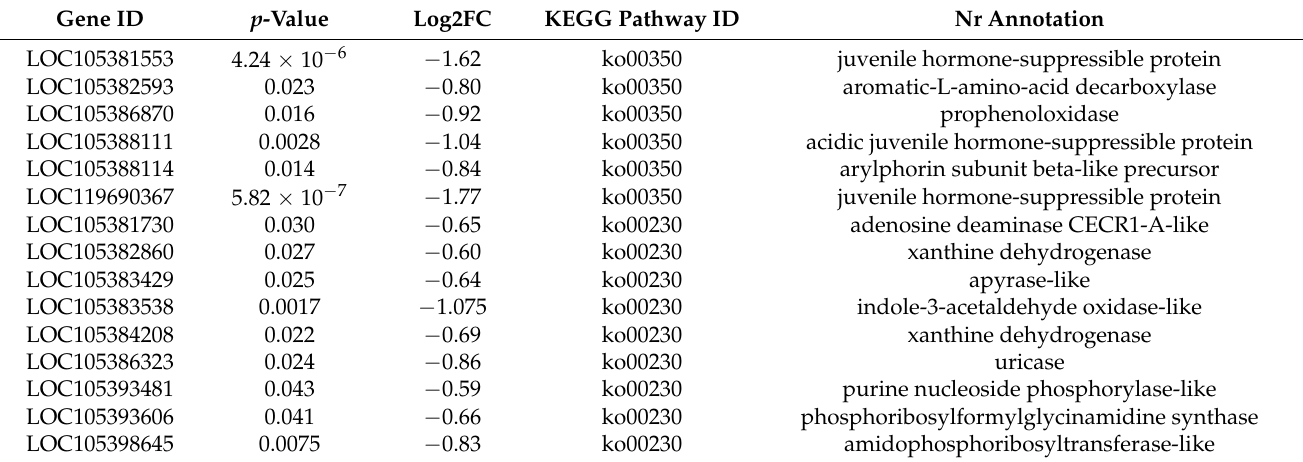
Table 3. The down-regulated genes that involved in tyrosine metabolism and purine metabolism pathways were identified in bifenazate treatment of Plutella xylostella